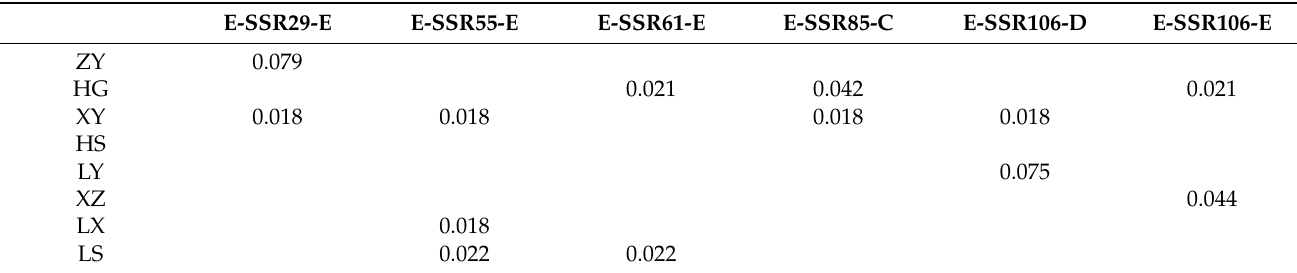
Table 7. Rare allele frequencies within the T. sebifera populations.